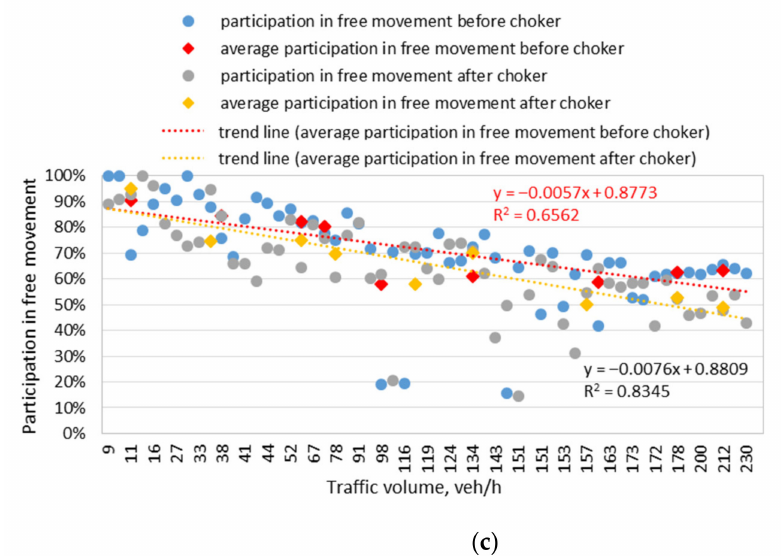
Figure 7. Variation in the share in free movement using the data obtained in the testing grounds: ( a ) No. 1; ( b ) No. 2; ( c ) No. 3. Source: own work of the